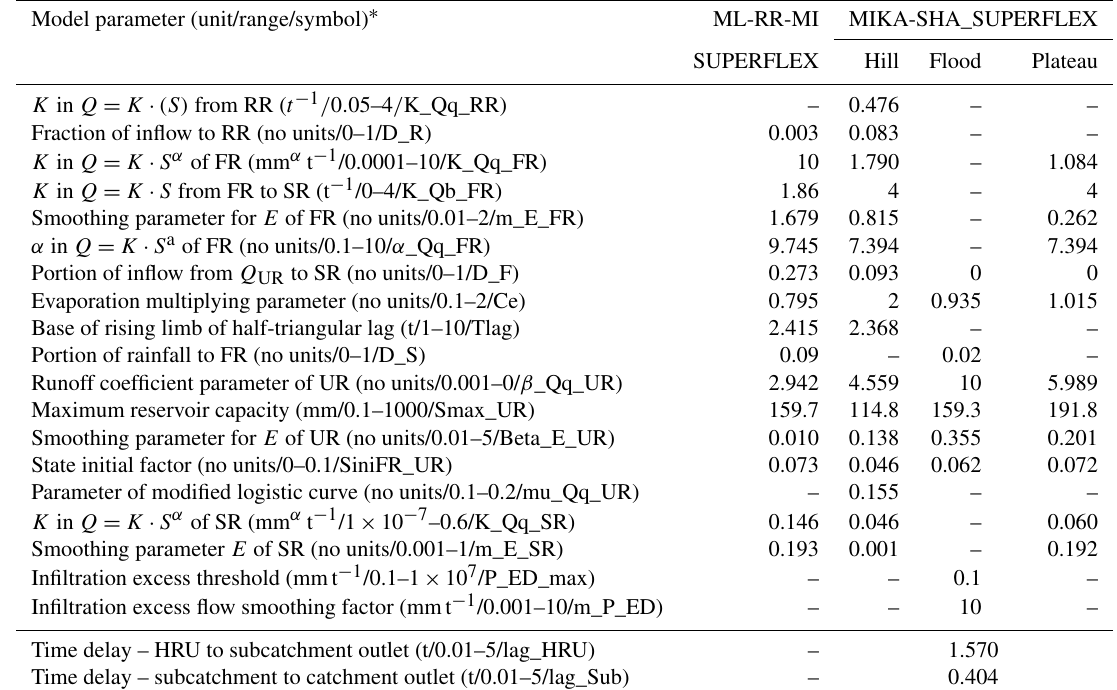
Table A1. Model parameter details of ML-RR-MI_SUPERFLEX and MIKA-SHA_SUPERFLEX. Model parameter (unit/range/symbol)